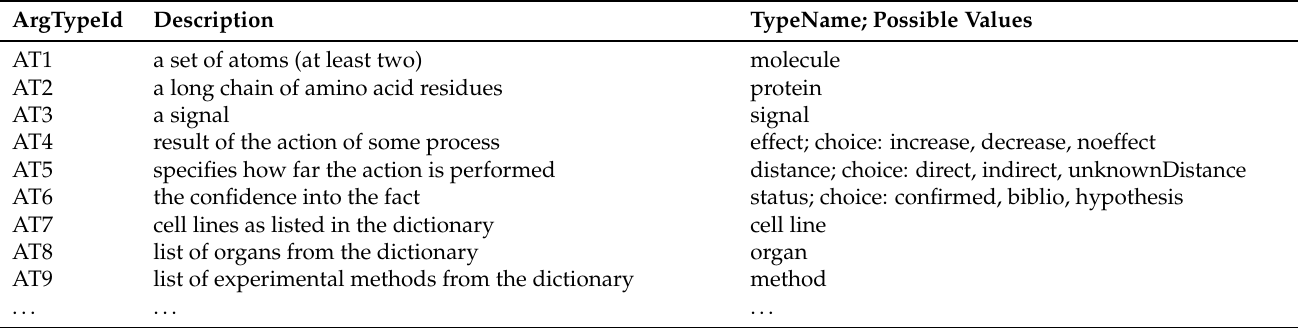
Table 8. The ArgumentType